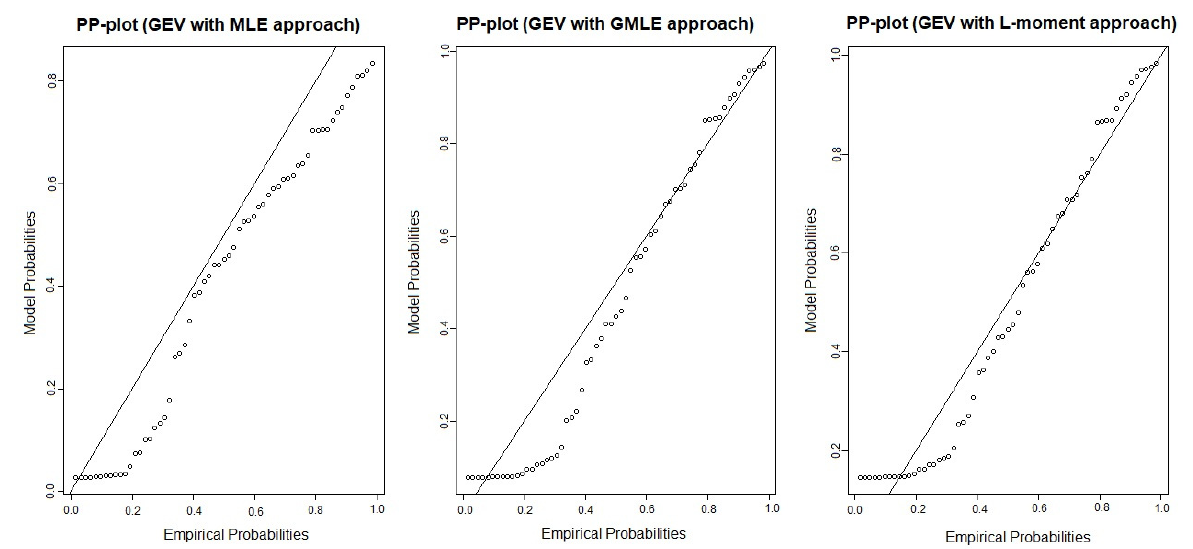
Figure 8. PP ‐ plot on the fitted GEV model based on different estimation approaches. Figure 8. PP-plot on the fitted GEV model based on different estimation